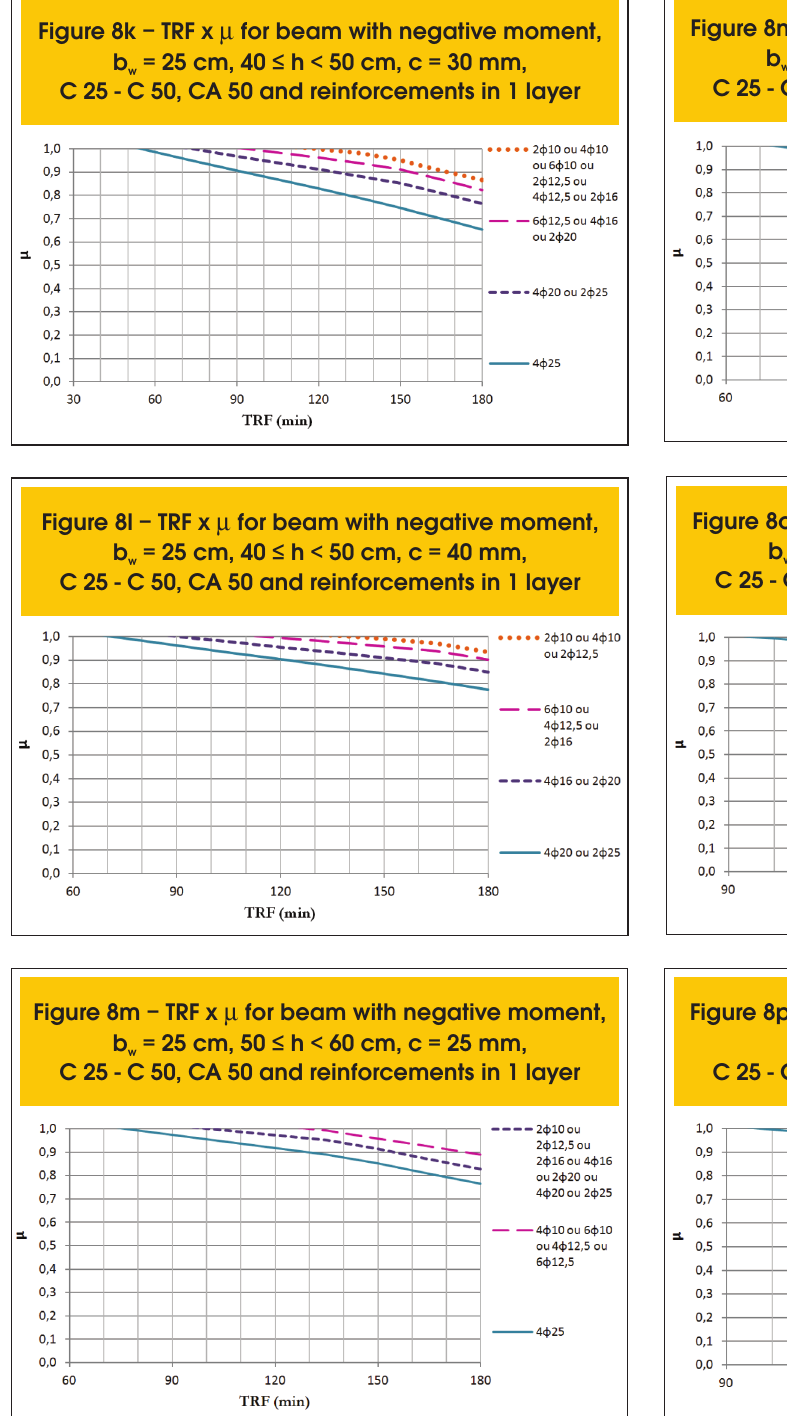
b = 25 cm, 40 ≤ h < 50 cm, c = 30 mm, w